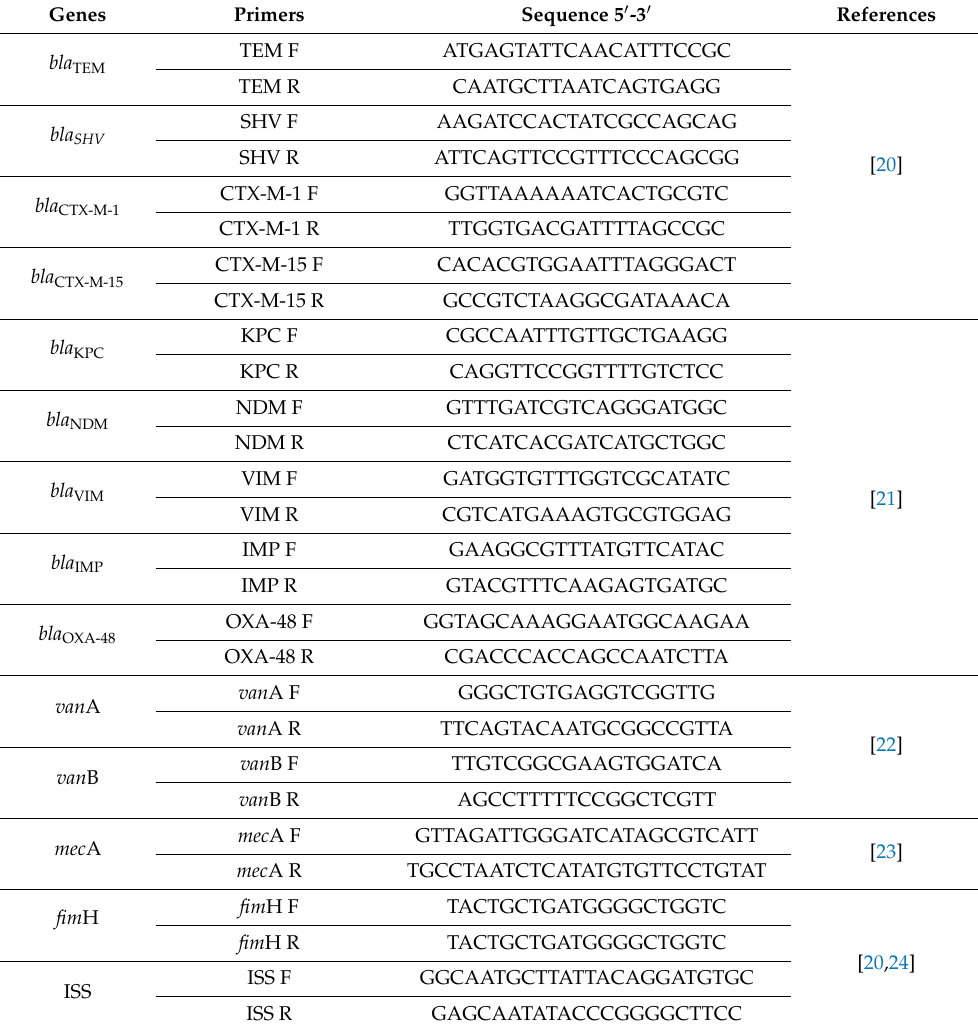
Table 1. List of genes searched and their different